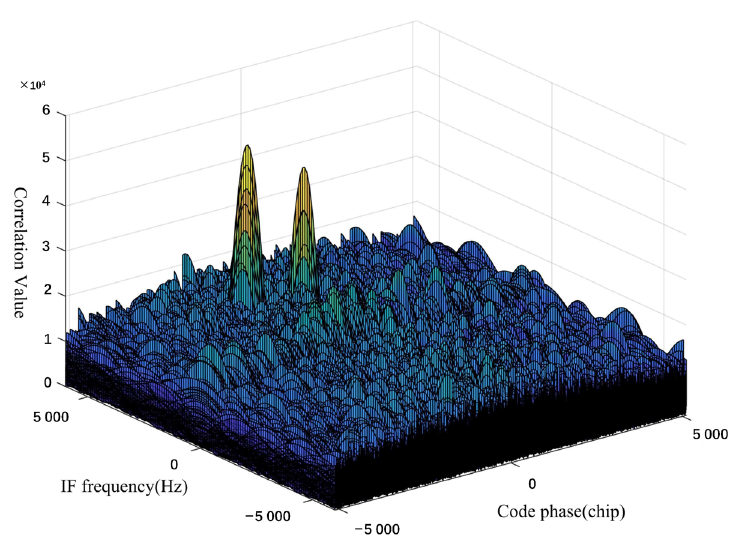
Figure 7. Schematic diagram of frequency-code two-dimensional correlation peaks in spoofing interference environment.